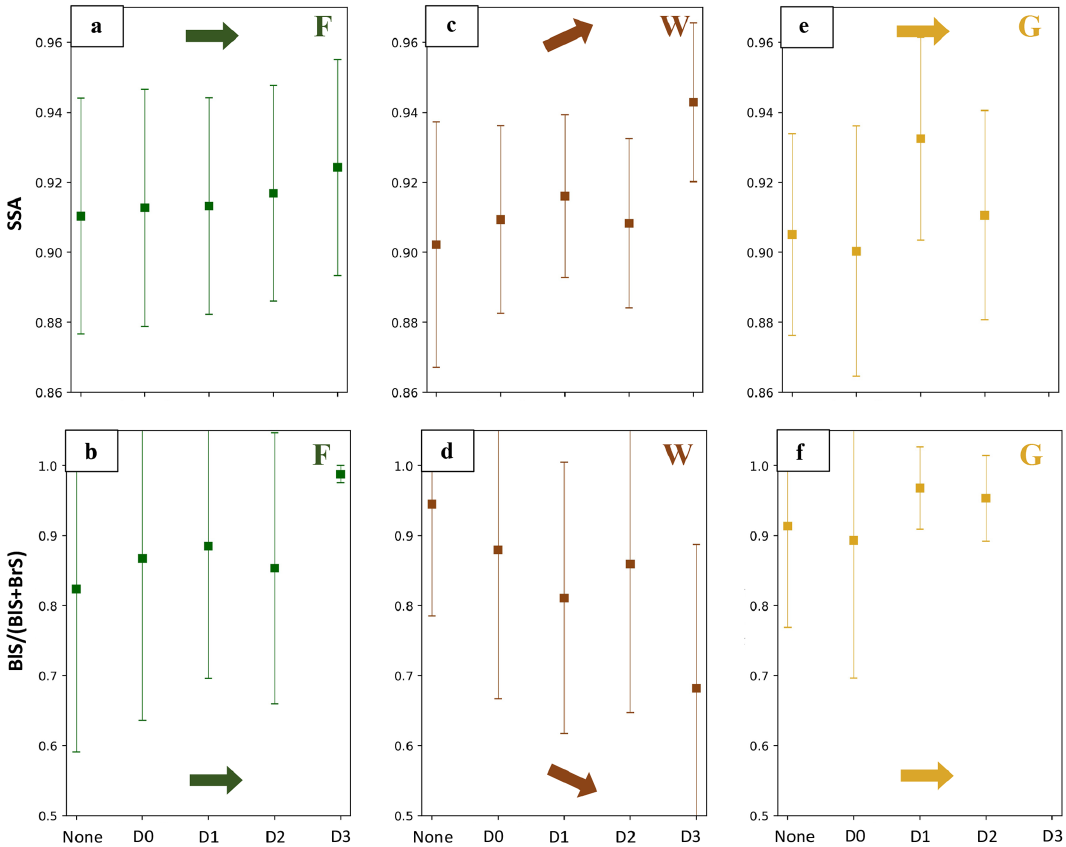
Figure 9. MISR mid-visible single-scattering albedo (a, c, e) and the fraction of AOD from BlS vs. the sum of both BlS and BrS (b, d, f) for different drought conditions. Decreasing values indicate lower amounts of BrS and higher amounts of BlS. Panels are color-coded by plume type and identified with the appropriate abbreviation in the top right-hand corner. Points represent the mean, and whiskers are the standard deviations. Arrows help highlight the general trends with increasing drought index: up or down arrows signify that the trends are statistically significant, and flat arrows indicate that they are not. Note that the D2 category presents an outlier for the otherwise clear trends in SSA and BlS / (BlS + BrS) for Woody plumes; for F and G plumes, there is no statistically significant response to increasing drought severity for either